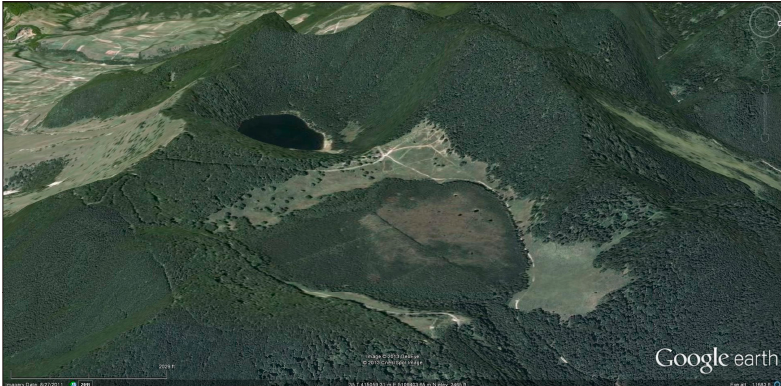
Figure 25. Google Earth capture of the summit part of Ciomadul volcano with the two craters: Sf. Ana (dark colored) and Moho ș (center of the figure).